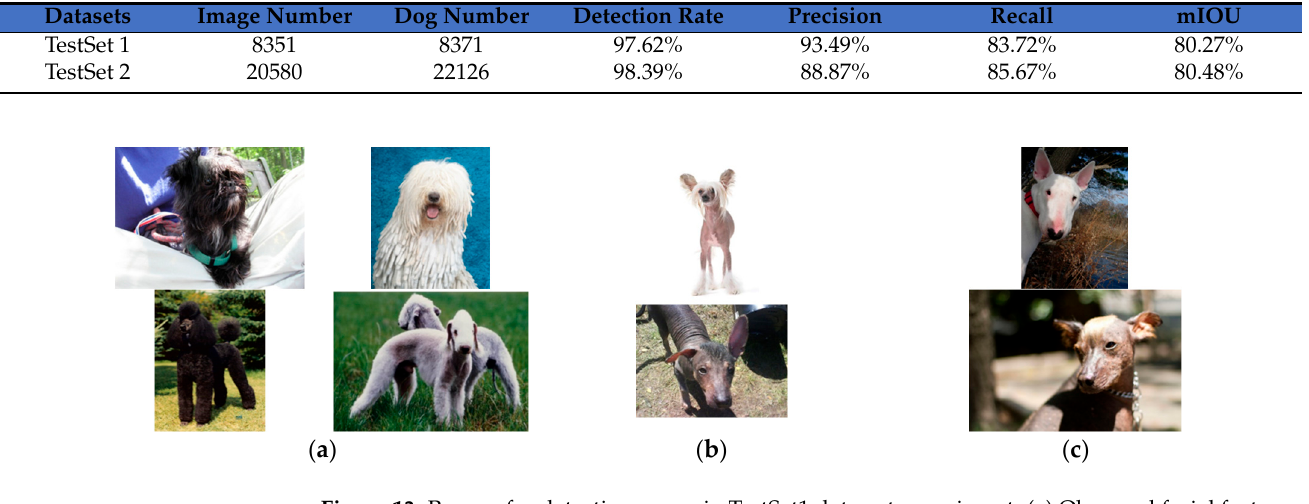
Table 11. Results of dog detection experiments.